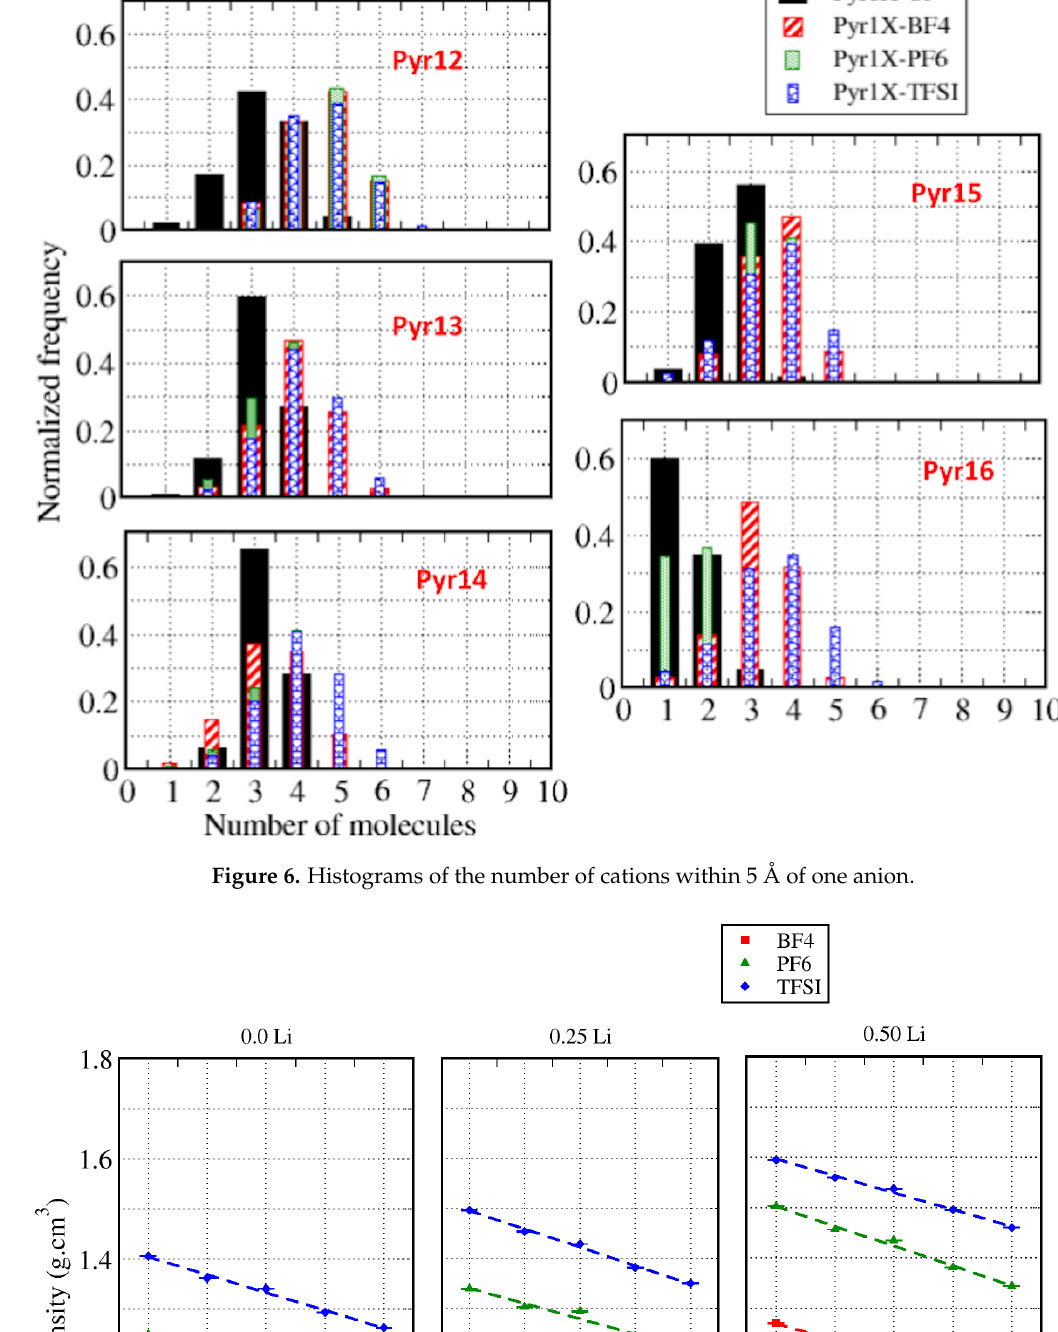
Figure 7. Densities for all systems with different amounts of